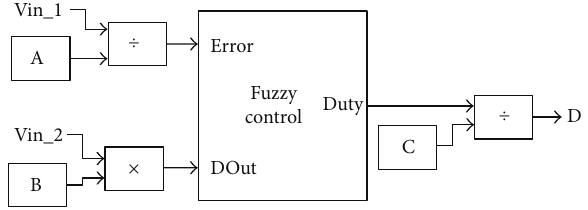
Figure 3: Schematic representation of the fuzzy control system.